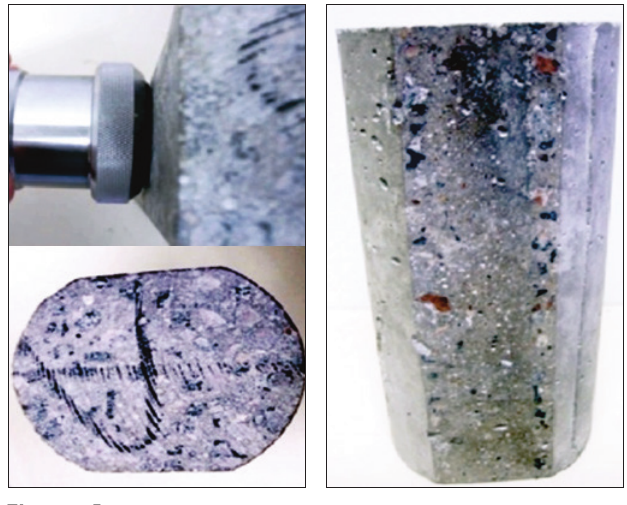
Retificação dos corpos de prova para acoplar os